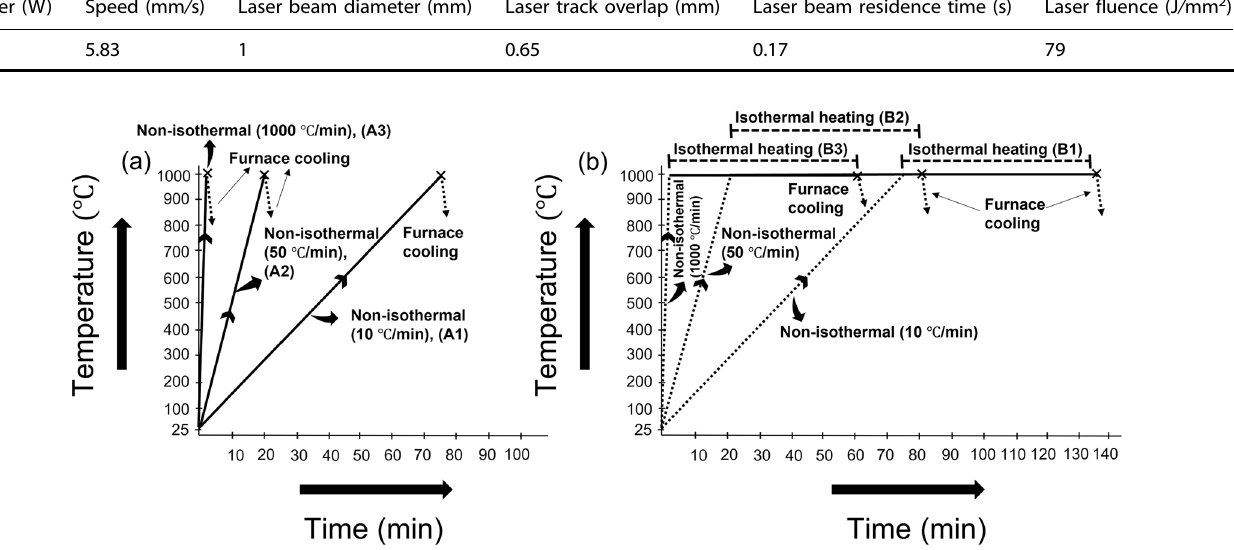
Fig. 6 Schematic of oxidation thermal treatments of L-DED fabricated IN718. a Non-isothermal oxidation with heating rates of 10 °C/min (A1), 50 °C/min (A2), and 1000 °C/min (A3) until 1000 °C followed by furnace cooling to room temperature (23 °C), and b isothermal oxidation with heating rates of 10 °C/min (B1), 50 °C/min (B2), and 1000 °C/min (B3) until 1000 °C followed by isothermally holding at 1000 °C for 1 h and then furnace cooling to room temperature (23